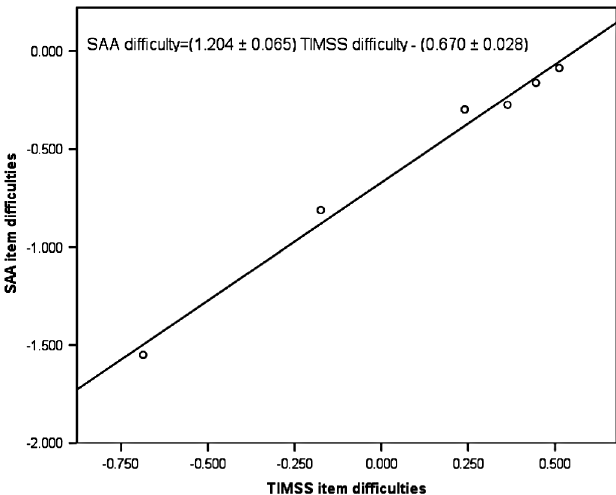
FIG. 1. Cross-plot of item difficulties for six item pairs from our